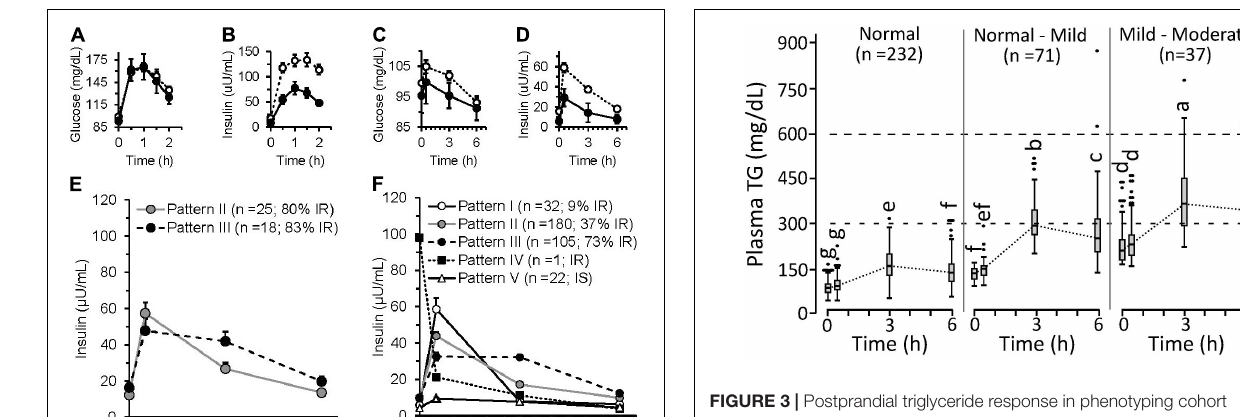
FIGURE 3 | Postprandial triglyceride response in phenotyping cohort individuals characterized with normal triglyceridemia, normal triglyceridemia to mild hypertriglyceridemia, mild-to-moderate hypertriglyceridemia. Cutoffs established for the normal, normal-mild, and mild-moderate postprandial triglyceridemia were < 11.15, > 11.15 and < 14.47, and > 14.47 mg/ml h − 1 for the 6 h area under the triglyceride curve calculated from the 0, 3, and 6 h plasma measurements (i.e., 6h AUC TG ). Measurements that do not share annotations differ at p < 0.05 by Tukey’s HSD post hoc analysis. The normal group 0 to 3 h slopes differ from other groups ( p < 0.0001). The normal-mild group 3 to 6 h slopes differ from other groups ( p < 0.0016). Results represent means ± standard